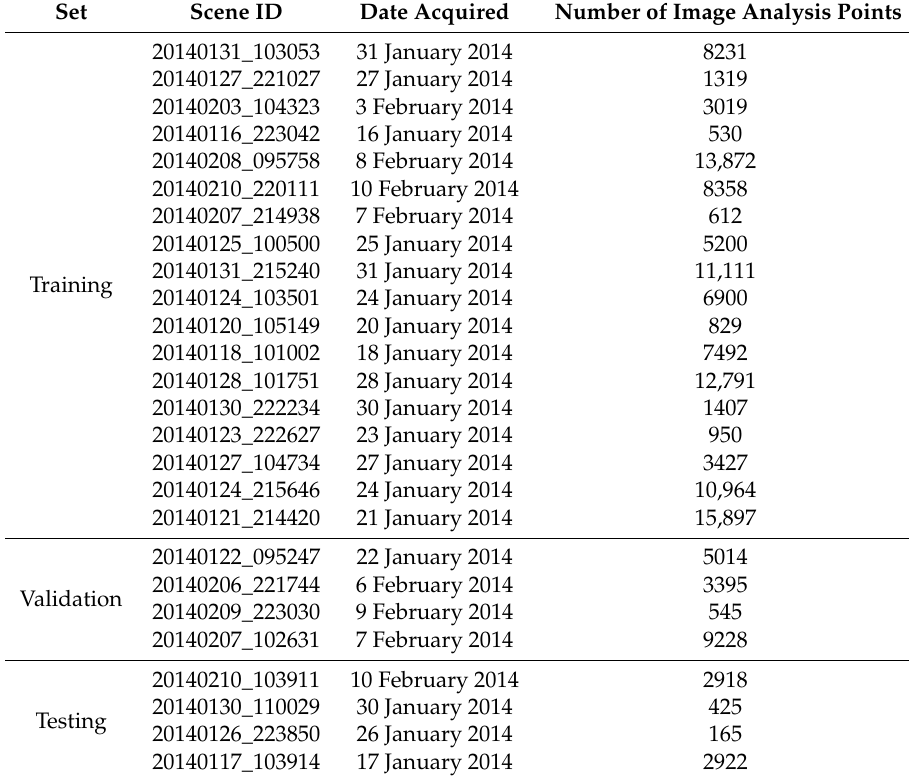
Table 1. Details of the Gulf of Saint Lawrence dataset. Each image analysis point covers an area of approximately 5 km × 8